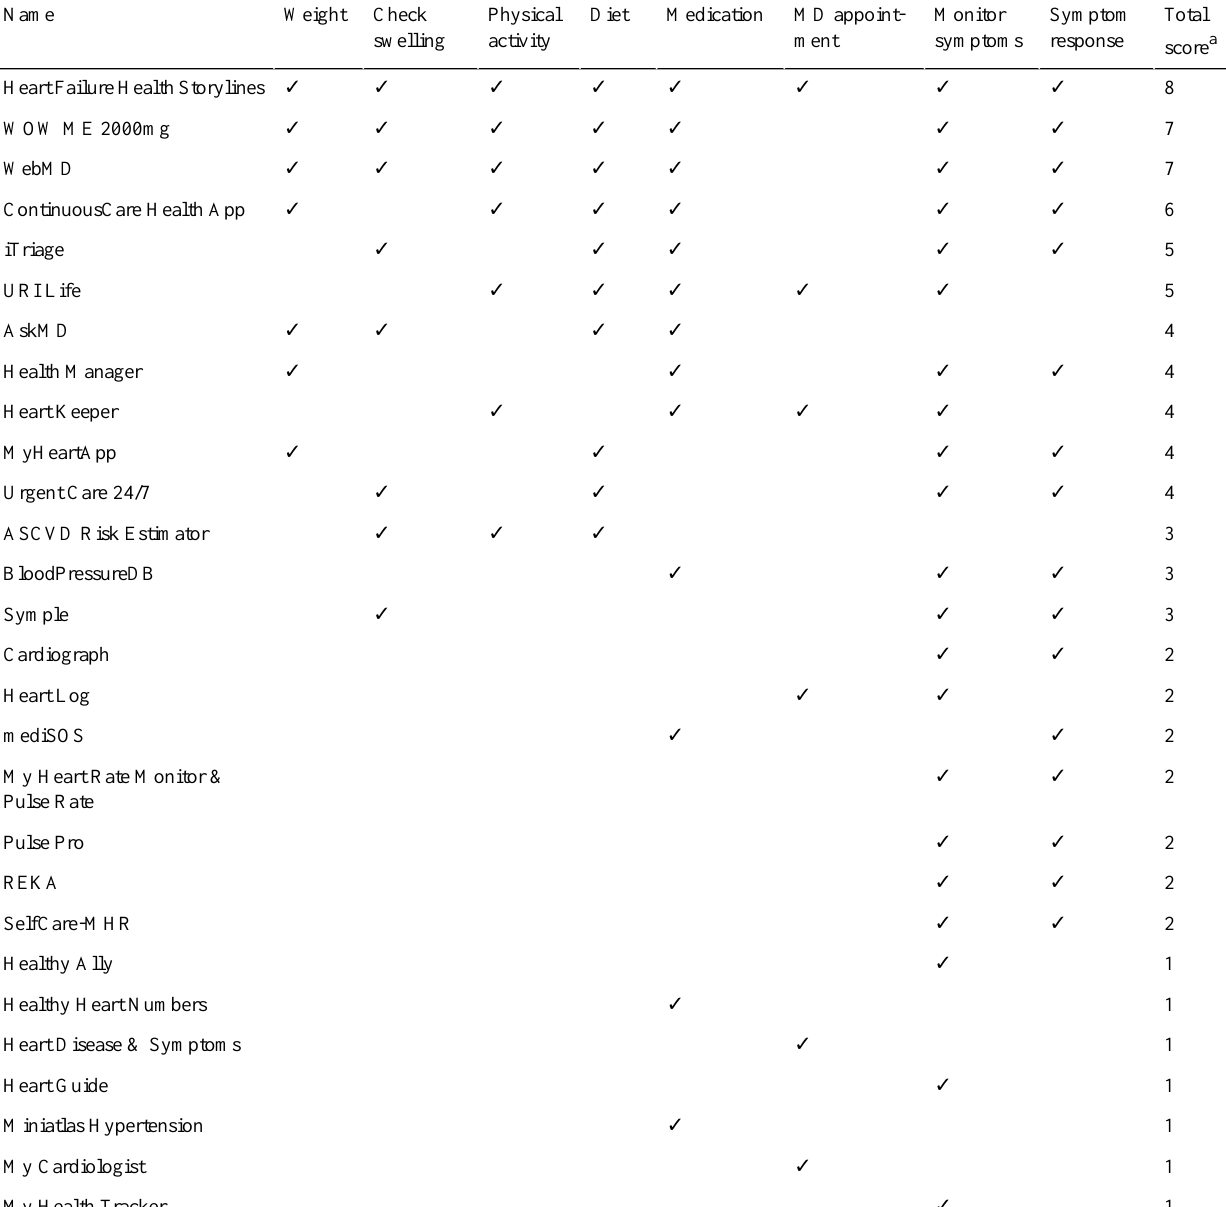
Table 4. Heart Failure Society of America–recommended nonpharmacologic management behaviors included in the